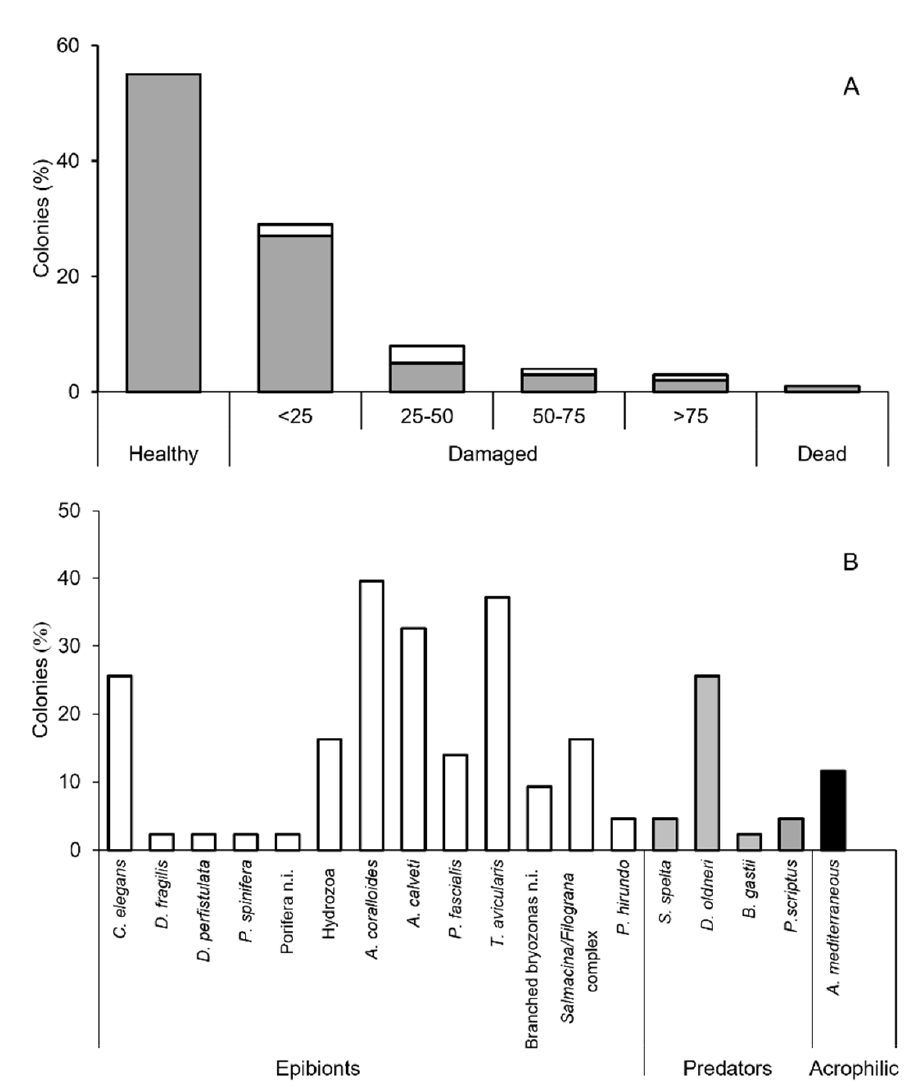
Figure 4. Health state of the studied Eunicella verrucosa population. ( A ) percentage of healthy and damaged colonies, according to the percentage of affected surface. White bars, percentage of colonies characterized by naked skeleton; grey bars, percentage of surface covered by epibionts. ( B ) percentage of colonies hosting associated species/OTUs.